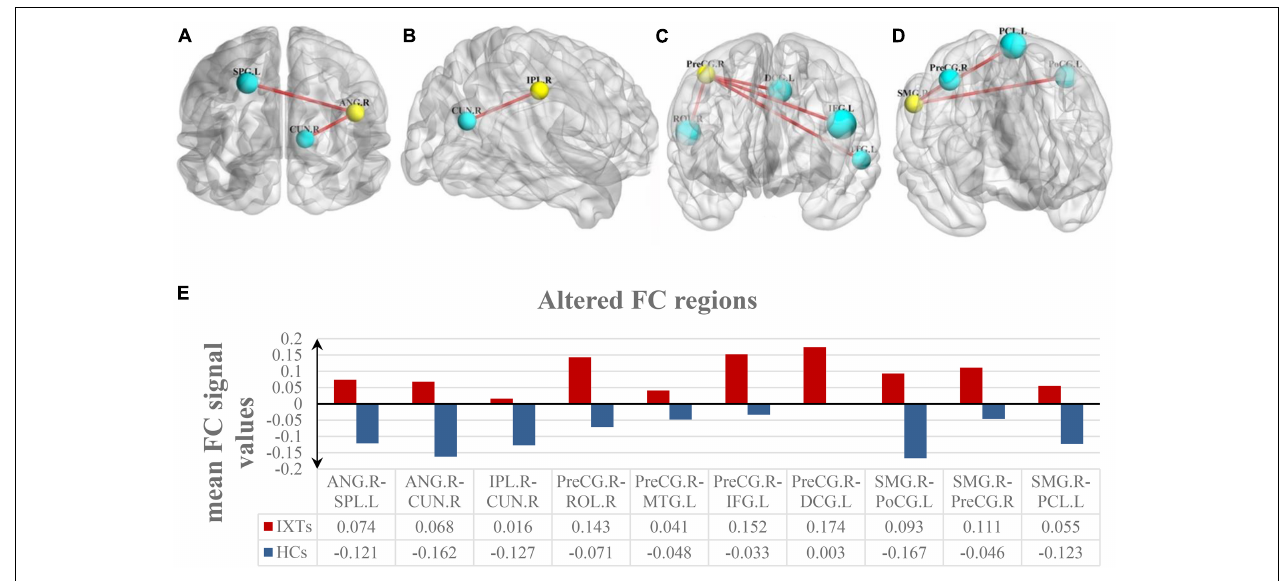
FIGURE 4 | Intergroup comparison of voxel-wise FC between the IXT patient and HCs. FC between the right ANG and right CUN, left SPL was significantly increased (A) . FC between the right IPL and right CUN was significantly increased (B) . FC between the right PreCG and right ROL, left MTG, left IFG, and left DCG was significantly increased (C) . FC between the right SMG and left PoCG, right PreCG and left PCL was significantly increased (D) . The yellow balls indicate the seed ROI, while the cyan balls indicate the ROIs with significantly different FC values. The size of the cyan balls corresponds to the t -values from the two-sample t -tests. The mean FC values of altered brain region is shown in (E) and the details of the negative regions can be found in Table 4 . ANG: angular gyrus; SPL: superior parietal lobule; CUN: cuneus; IPL: inferior parietal lobule; PreCG: precentral gyrus; ROL: rolandic operculum; MTG: middle temporal gyrus; IFG: inferior frontal gyrus; DCG: median cingulate gyrus; SMG: supramarginal gyrus; PoCG: postcentral gyrus; PCL: paracentral